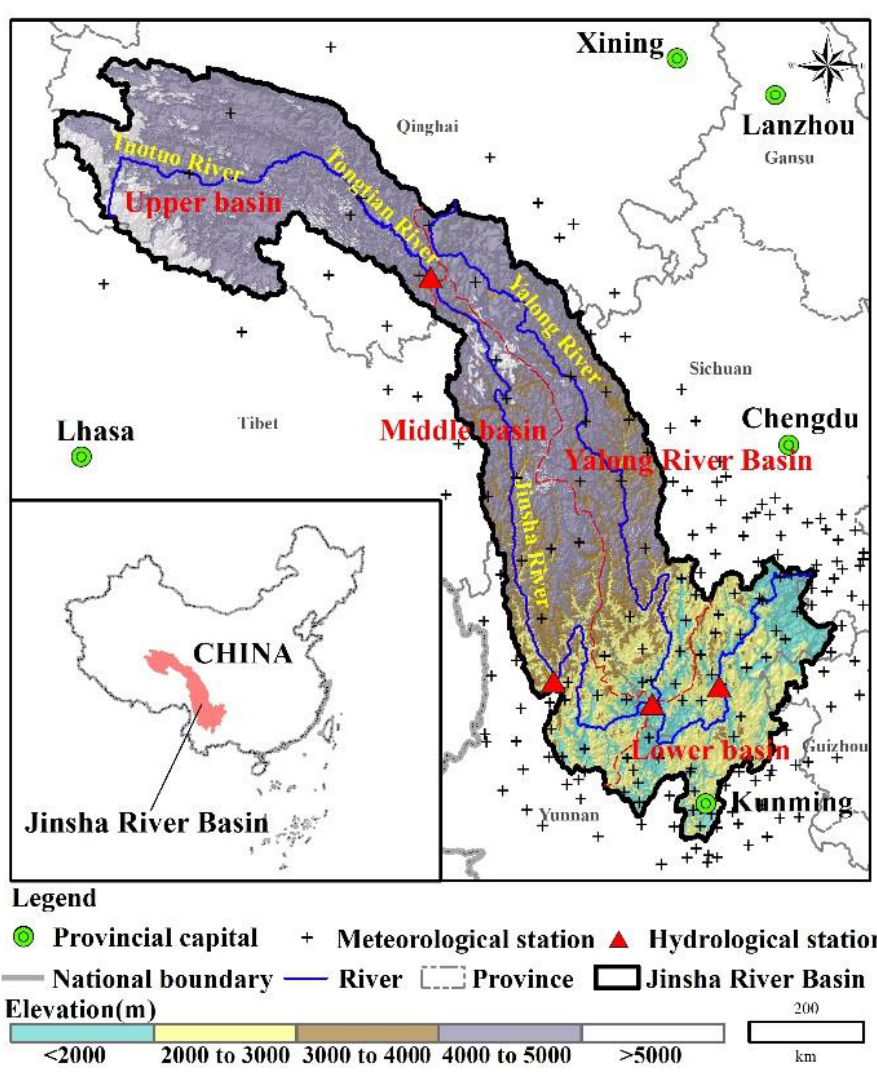
Figure 1. Location of Jinsha River Basin.